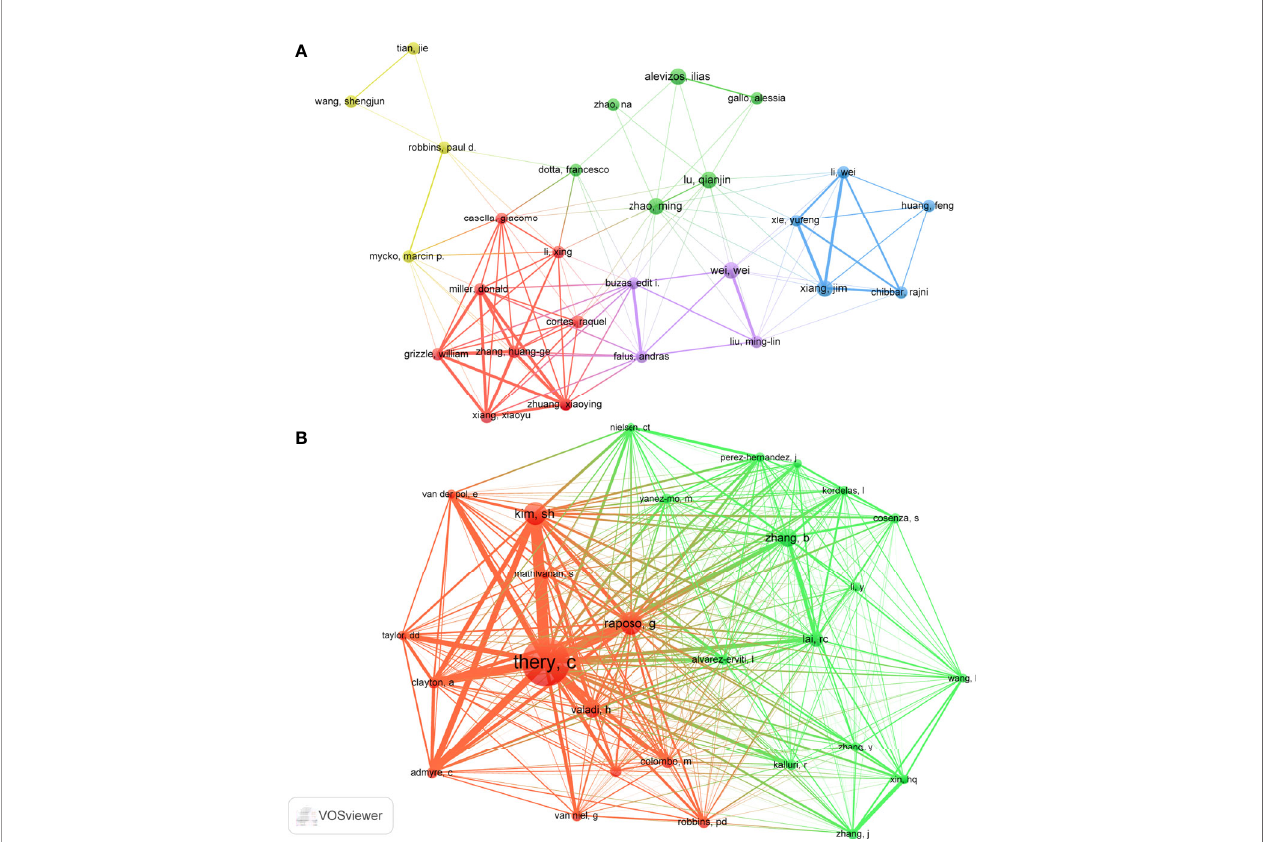
FIGURE 7 | The visualization of authors (A) and co-cited Authors (B) on research of exosomes in